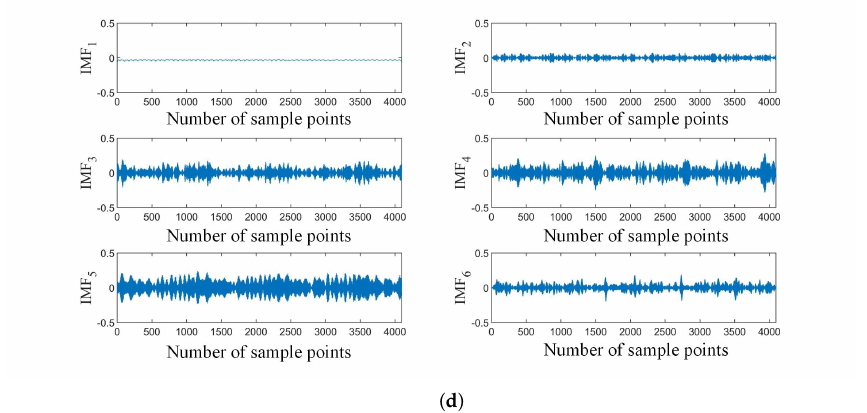
Figure 11. IMF of vibration signals of the ER–12K rolling bearing in 4 states after VMD. ( a ) Inner race fault, ( b ) Outer race fault, ( c ) Rolling element fault, ( d ) Normal state.